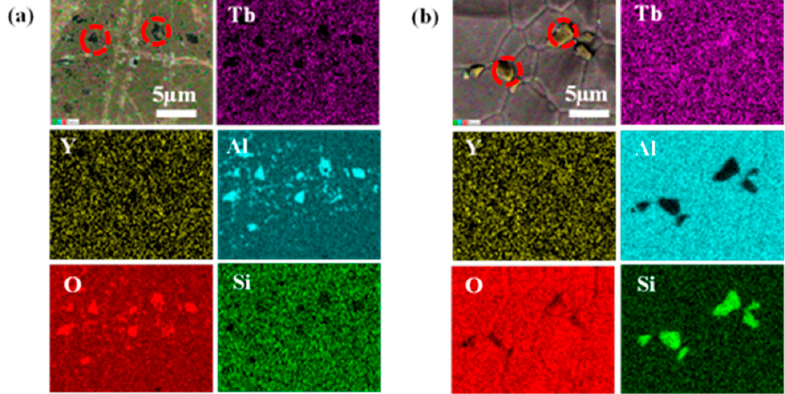
Figure 4. Energy dispersive spectroscopy of two ratios pre-sintered at 1450 °C: ( a ) 0.6000, ( b ) 0.6073.